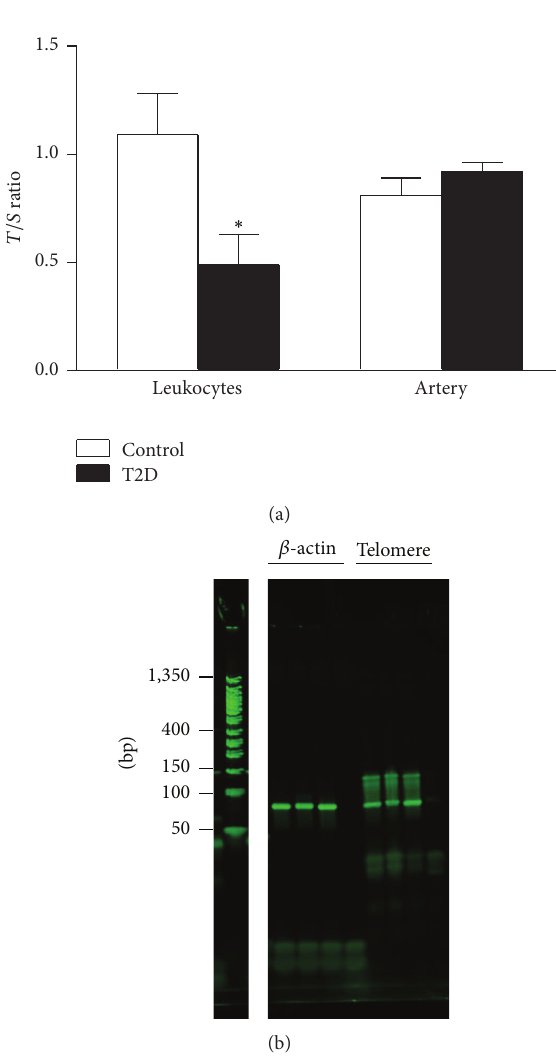
Figure 2: (a) Leukocyte 𝑇/𝑆 ratio was significantly lower in T2D rats compared to control rats ( 𝑃 = 0.034 ; 𝑡 -test). Femoral artery 𝑇/𝑆 ratio was comparable between T2D and control rats ( 𝑃 = 0.28 ). (b) qPCR products for rat 𝛽 -actin and telomere primers. Lane 1: DNA ladder; lanes 2 and 6: rat leukocyte calibrator DNA; lanes 3 and 7: control rat leukocyte DNA; lanes 4 and 8: T2D rat leukocyte DNA; lanes 5 and 9: no template control (H 2